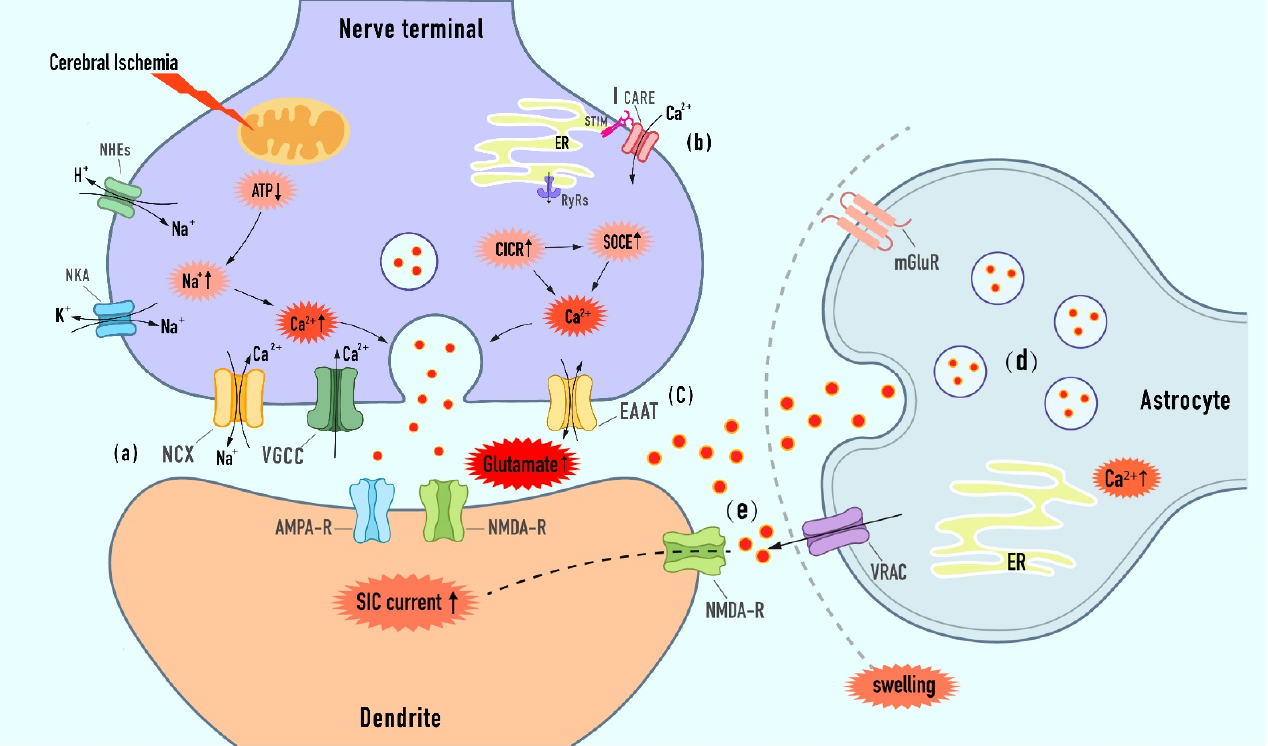
Figure 2. Excessive synaptic or extra-synaptic glutamate release mechanisms in ischemic stroke. (a) Owing to the failure of ATP- powered ionic pumps, the presynaptic Ca 2+ elevation results from the reverse of NCX and the sustained activation of VGCC, both of which organize and regulate the releasing of vesicle glutamate. (b) On the one hand, Ca 2+ influx into cytoplasmic via IP3Rs and RyRs during CICR. On the other hand, SOCE is triggered by the depletion of calcium in the ER, and Ca 2+ is released via STIM-CRAC interaction, thereby inducing the augment of vesicle glutamate release. (c) Glutamate transporter reversal under the conditions of stroke increases the glutamate concen- tration in the ambient and develops excitotoxicity. (d) Astroglia Ca 2+ elevations derived from extra- cellular glutamate stimulation and ER internal stores trigger glutamate exocytosis release from as- trocytes to the adjacent neurons. (e) Activation of the VRAC channel and reduction of extracellular spaces during astrocyte swelling promote excessive glutamate release and effective concentration augment, then contributing to extra-synaptic NMDA-mediated SIC generation, which ultimately leads to excitotoxic neuronal death [53] (the vertical arrow in the explosive frame indicates the up- regulation or down-regulation of corresponding pathological process).